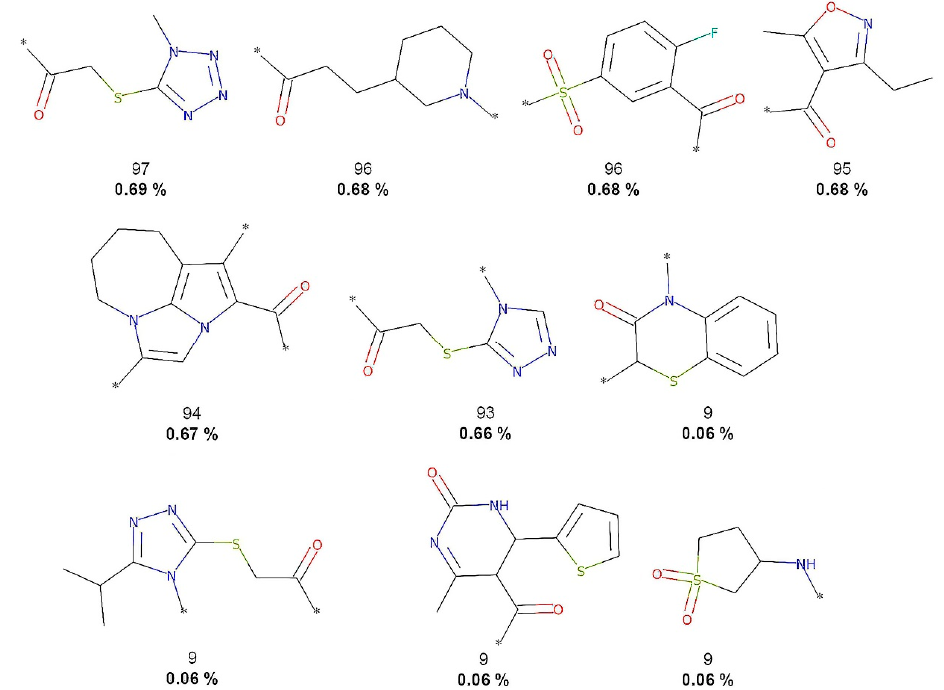
Figure 4. The 10 most frequent and unique DCM fragments. Frequency (regular font) and proportion (bold font) are listed below the chemical structures.